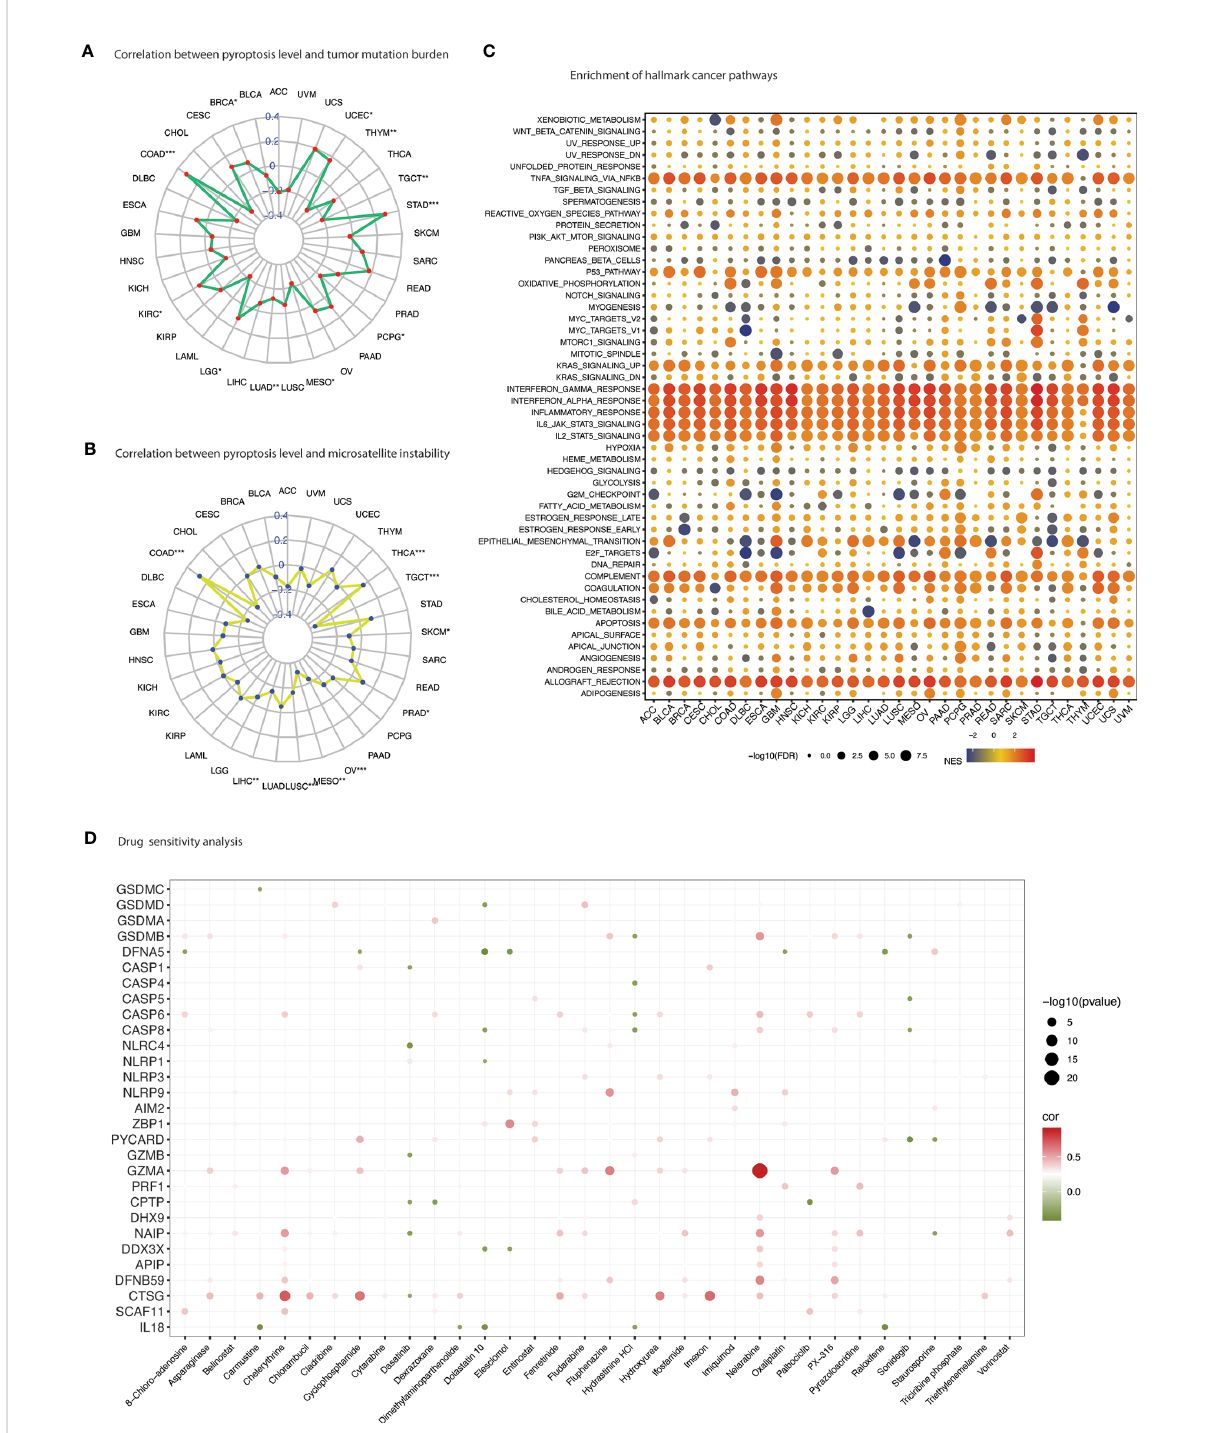
FIGURE 7 Therapeutic vulnerabilities. (A) Spider web plot summarizes spearman correlation between pyroptosis level and tumor mutation burden. * p value < 0.05; ** p value < 0.01; *** p value < 0.001. (B) Spider web plot summarizes spearman correlation between pyroptosis level and microsatellite instability. * p value < 0.05; ** p value < 0.01; *** p value < 0.001. (C) Enrichment analysis for hallmark cancer pathways between pyroptosis-high and pyroptosis-low tumor tissues. NES is the normalized enrichment score in the GSEA algorithm. (D) Drug sensitivity analysis of PRGs based on the CellMiner database. Green depicts negative correlation (sensitivity to drug) and red shows positive correlation (induction of gene